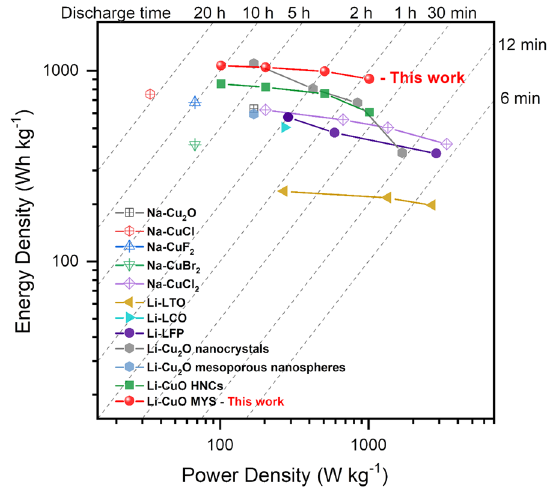
Fig. 5 Ragone plot for comparison of the energy density and power density among state‑of‑the‑art cathodes of Li/Na‑SO 2 battery with optimized rate performance as reported in the literatures.[6, 7, 9–11, 40,